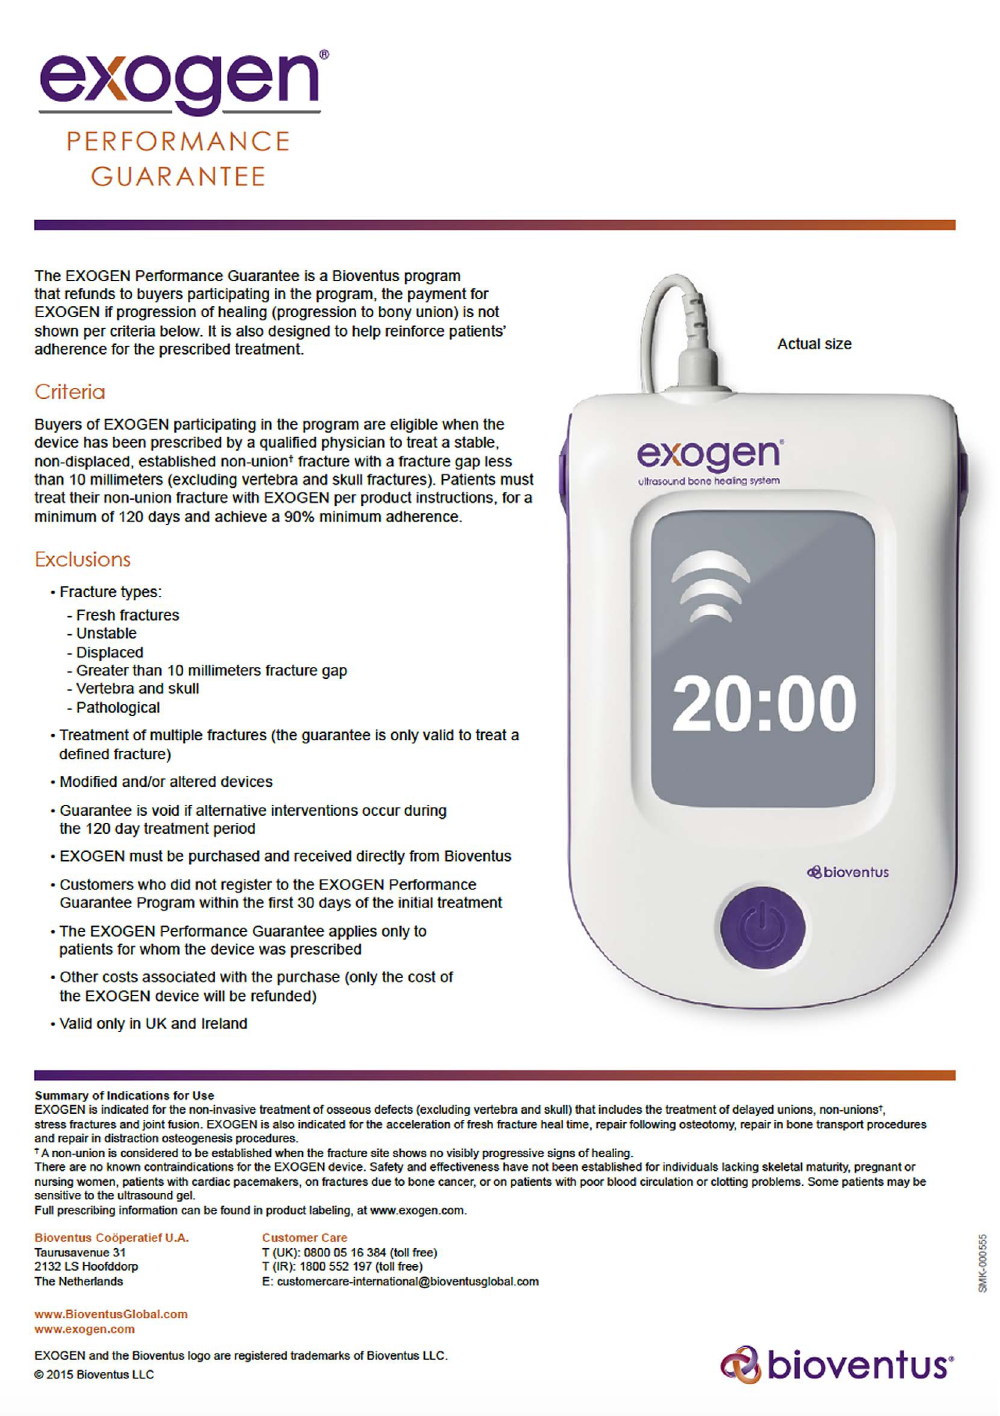
Figure B1. Bioventus ’ union or money back